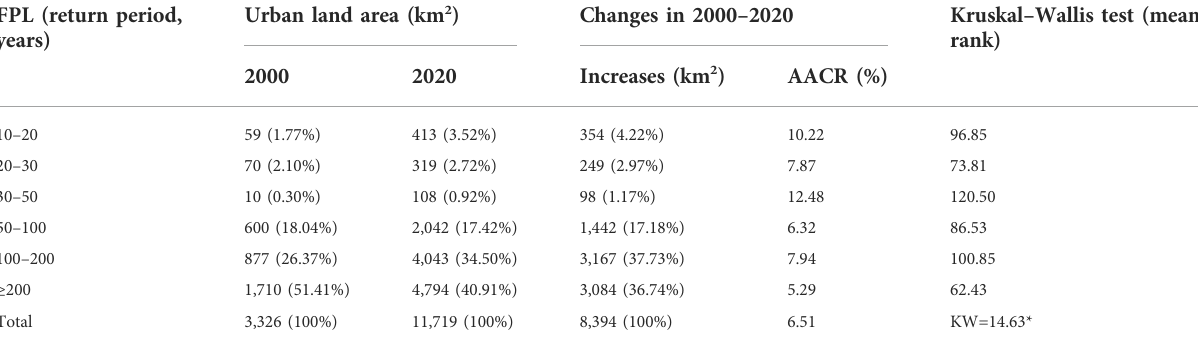
TABLE 1 The urban lands in CFAs and its changes under different FPLs during 2000 – 2020 in China and the results of the Kruskal – Wallis test. FPL (return period,